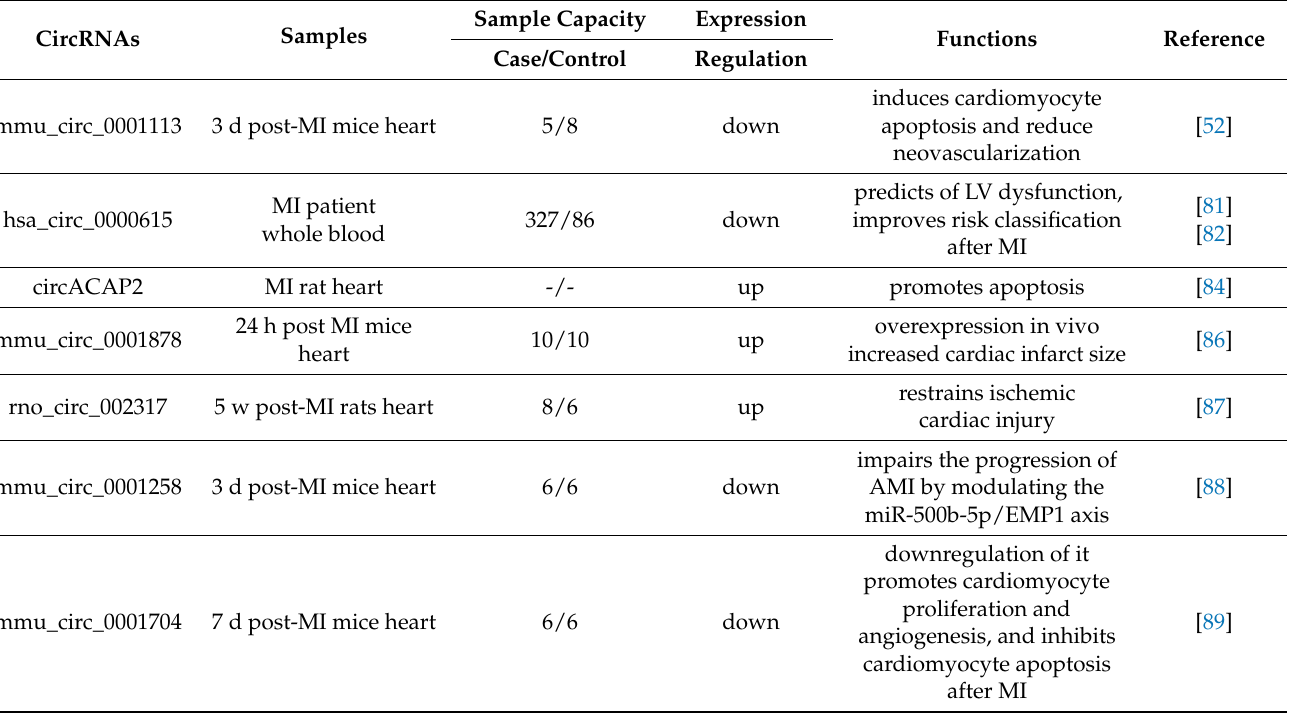
Table 3. CircRNAs as potential biomarkers in myocardial infarction validated by real-time RT-qPCR.